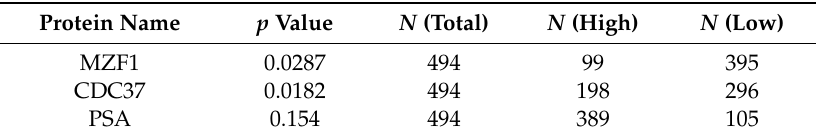
Table 1. Correlation between protein expression and prognosis of prostate cancer